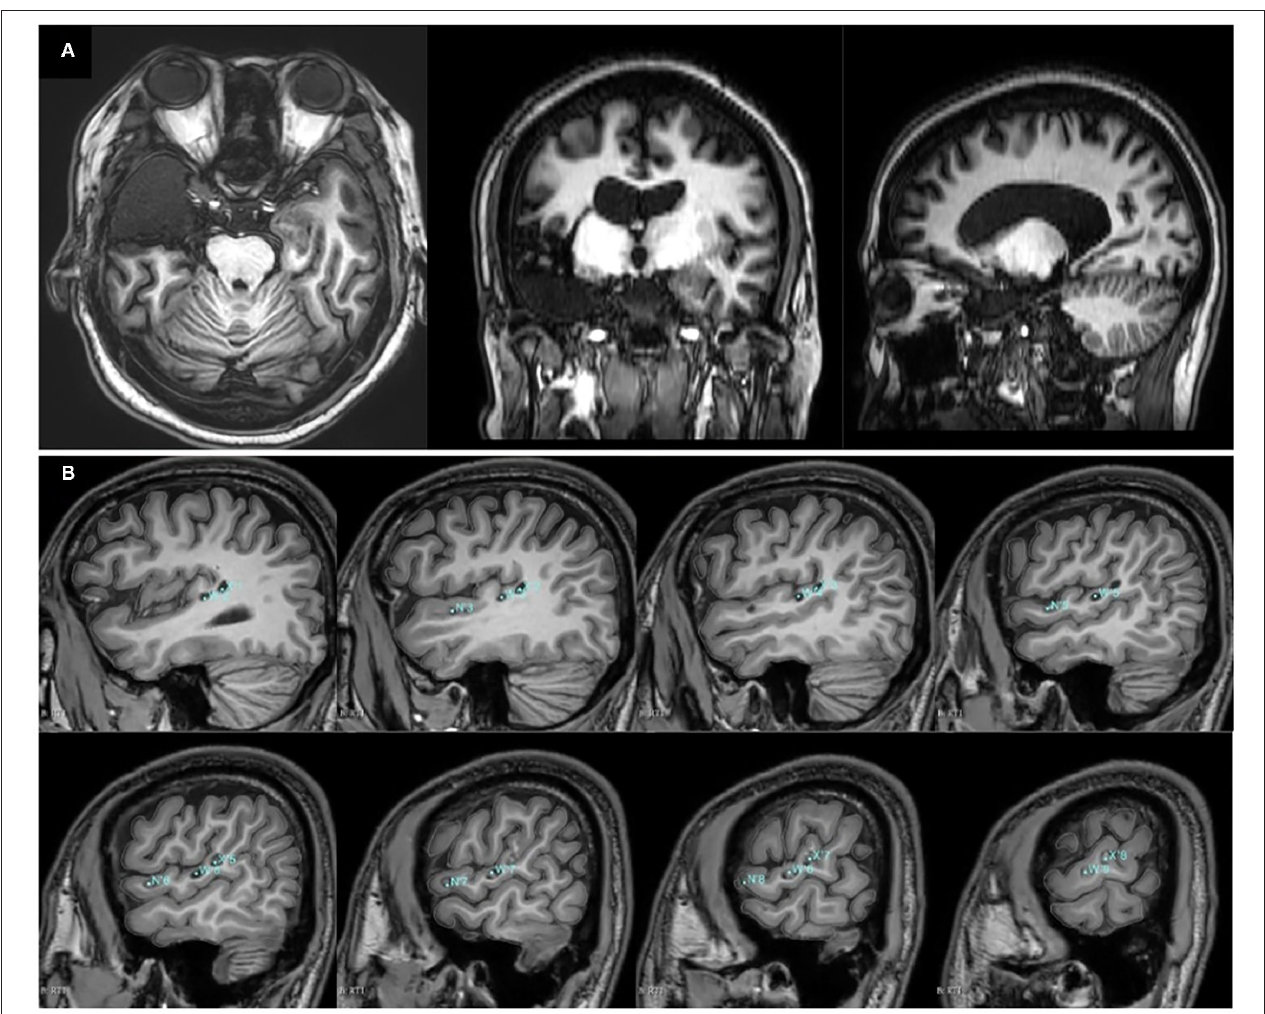
FIGURE 3 | Postoperative T1-weighted MRI results. (A) T1-weighted MRI results of case 1 after the right anteromedial temporal lobe and insular lobe resection. (B) T1-weighted MRI results of case 2 after SEEG-guided radiofrequency thermocoagulation (RFTC). The locations and labels of the electrodes for the thermocoagulation were marked in